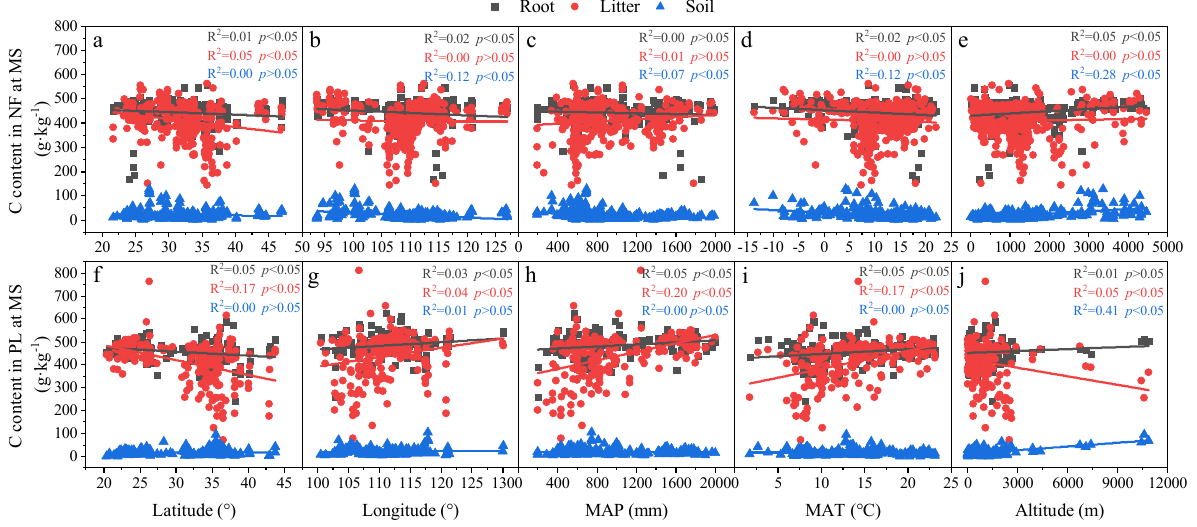
Figure A2. C content changes with latitude ( a , f ), longitude ( b , g ), mean annual precipitation (MAP) ( c , h ), mean annual temperature (MAT) ( d , i ) and altitude ( e , j ) in different forest origins in the middle stage (MS). The number of forest sites are 344 and 199 for NF − MS and PL − MS, respectively.